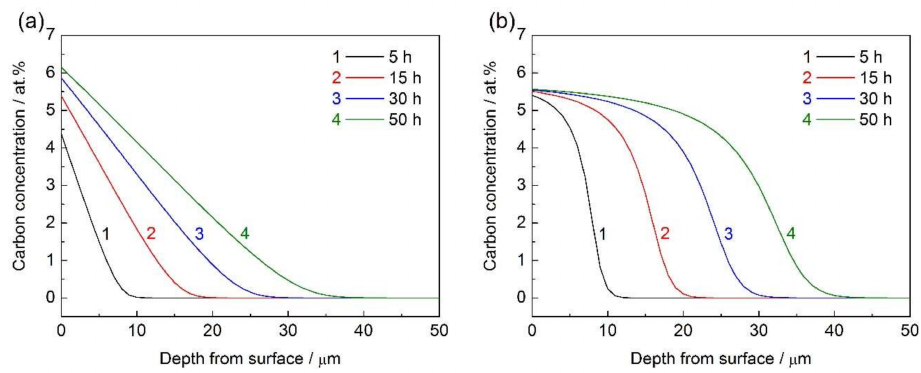
Figure 7. Calculated carbon concentration–depth profiles at different carburizing times: ( a ) at the diffusion sites; ( b ) at the trap sites.